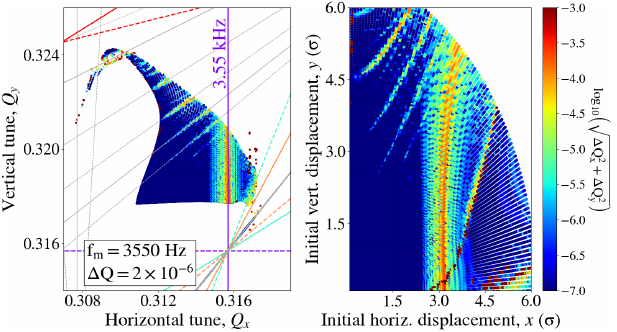
FIG. 9. Frequency map analysis (left) and initial configuration space (right) for the simulation parameters in Table II, a tune modulation at 3.55 kHz and without considering synchrotron oscillations. The purple line represents the m ¼ 1 and N ¼ 1 resonance [Eq. (17)], which is the dipolar excitation at 3.55 kHz in the horizontal plane.